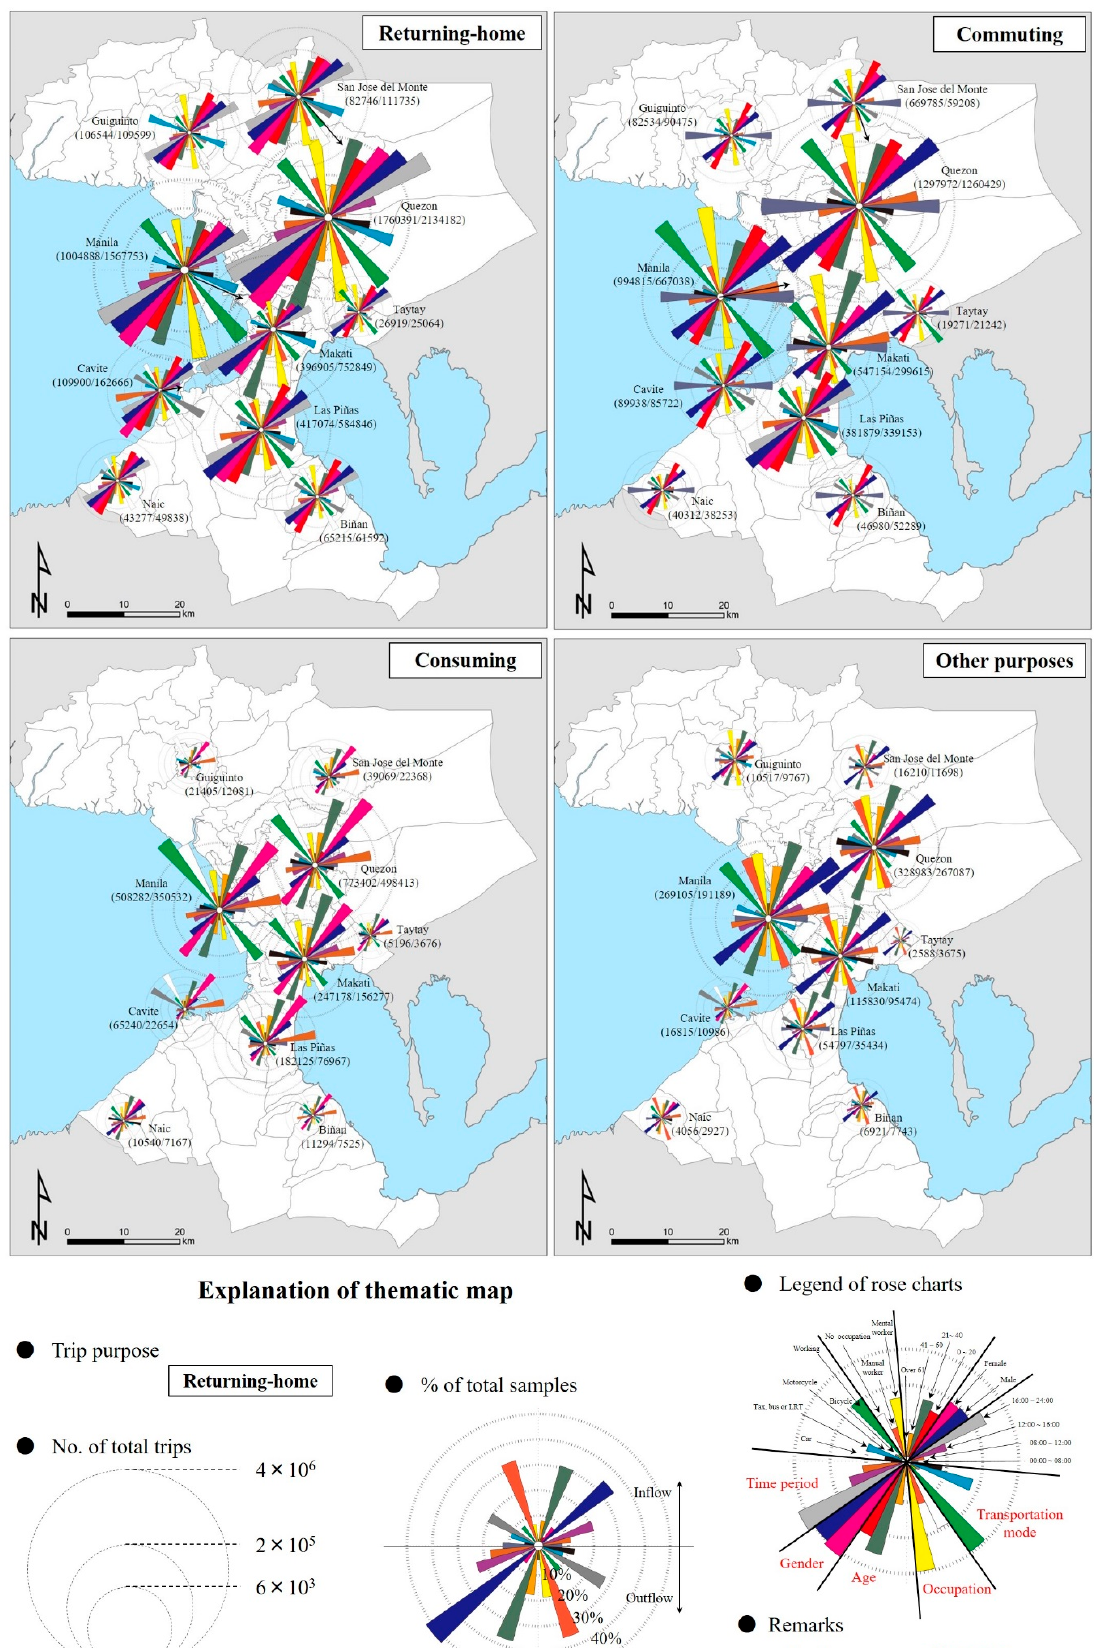
Figure 9. Pattern of human mobility by different properties in Manila metropolitan area based on different trip purposes.